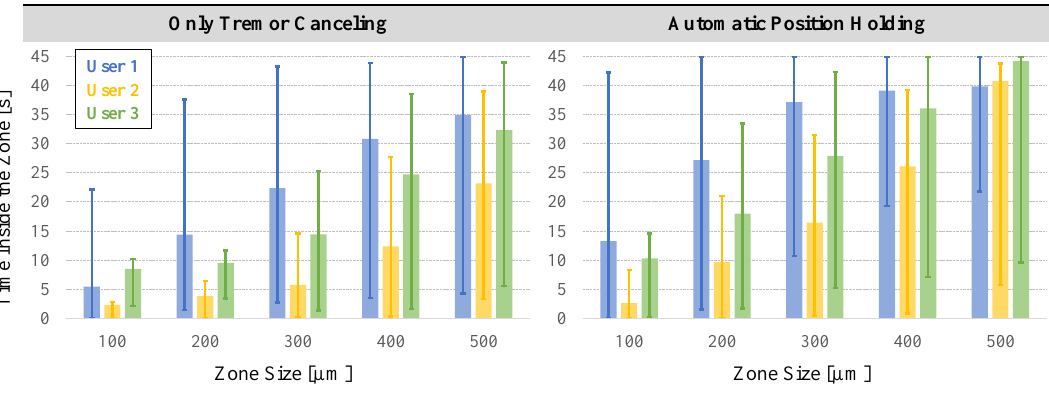
Figure 13. The performance of each user in maintaining the needle around the point of puncture (zone size = distance from the puncture point). User 1 is a non-surgeon with extensive experience on the robotic system. Users 2 and 3 are, respectively, an ophthalmology fellow and an expert vitreoretinal surgeon with some training on the robotic system. The solid bars show the mean, and the error bars represent the maximum and minimum values. The automatic position holding mode aids in maintaining the needle close to the puncture point for a longer period for all users.